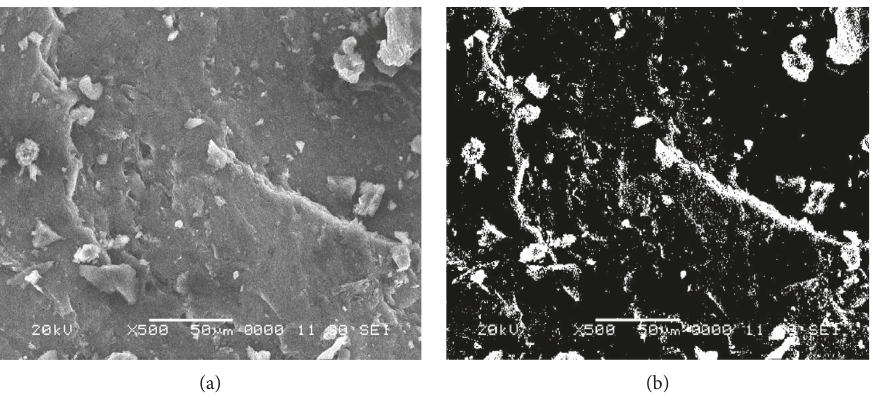
Figure 3: (a) SEM diagram and (b) binary diagram for the B-1 coal sample magnified